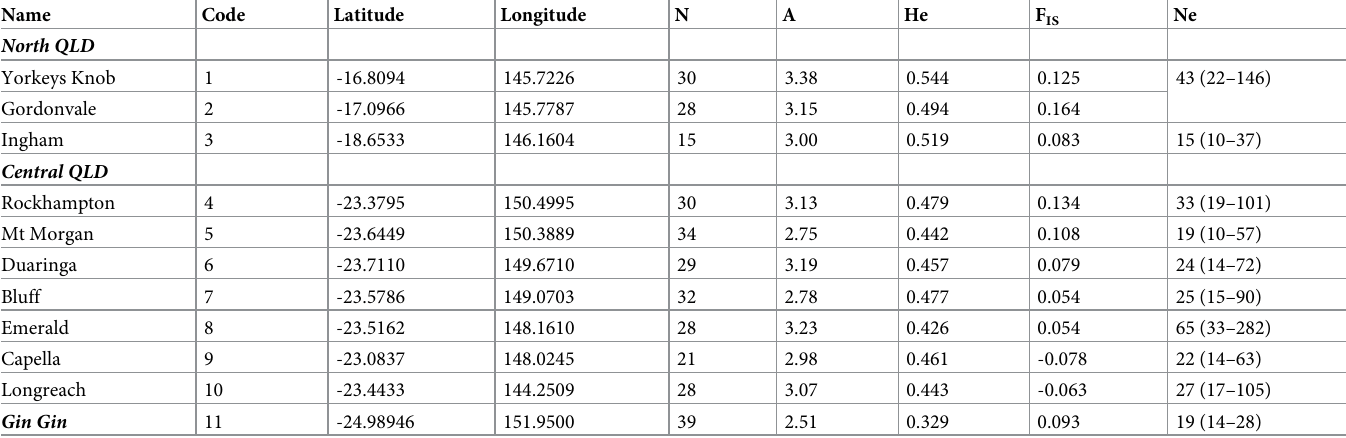
Table 3. Genetic diversity over seven microsatellite loci for Aedes aegypti from eleven locations in Queensland, Australia. Results grouped in regions (north Queens- land— NQL , and central Queensland— CQL ) with: sample size (N), allelic richness calculated from 15 individuals (A), gene diversity (He), inbreeding coefficient (F IS ), mean effective population size (Ne) and 95% confidence limits (in parentheses) (Table modified from Rasˇi ć et al . [35] to include data from Gin